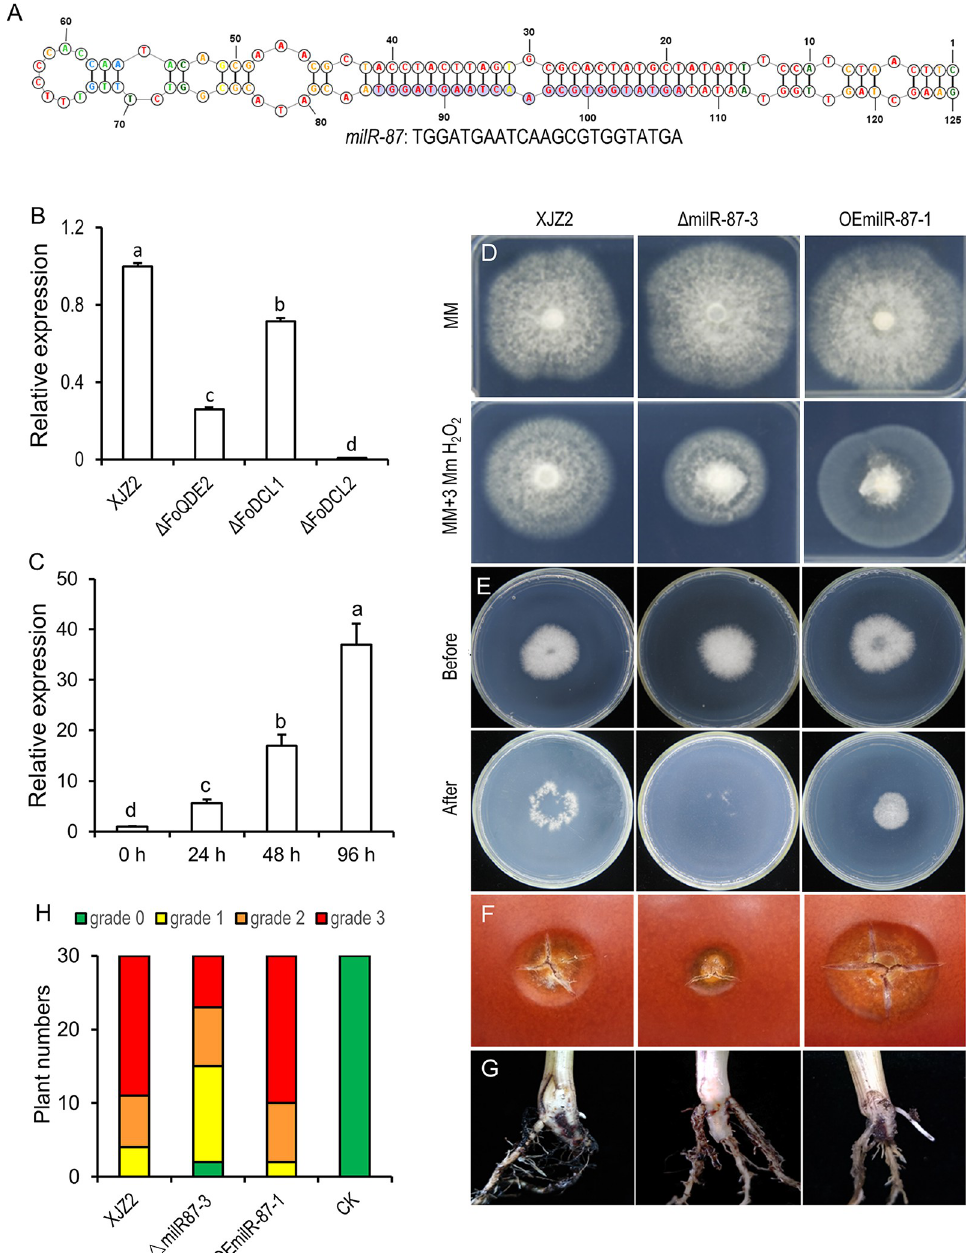
Fig 5. Characterization of FoQDE2-dependent milRNA ( milR-87 ) in F . oxysporum f. sp. cubense ( Foc ). ( A ) Predicted secondary structure of milR-87 precursor in Foc . ( B ) MilR-87 expression in different milRNA biosynthetic pathway gene deletion mutants ( Δ FoQDE2 , Δ FoDCL1 , and Δ FoDCL2 ) by qRT-PCR. Error bars indicate S.D. (n = 3). Different letters indicate significant difference at the level of α = 0.01. ( C ) Expression patterns of milR-87 at 0, 24, 48, and 96 hours post inoculation. Total RNAs were extracted from the host banana roots inoculated with Foc at the different time point (0–96 h). Relative expression levels of milR-87 were calculated by 2 - ΔΔ Ct method using snRNA (U4) as internal control. Error bars indicate S. D. (n = 3). Different letters indicate significant difference at the level of α = 0.01. ( D ) Mycelial sensitivity to H 2 O 2 . Mycelial growth of the WT strain XJZ2, the Δ milR-87 mutant ( Δ milR-87-3 ) and milR-87 over-expression strain OEmilR-87-1 were measured at MM with 0 and 3 mM H 2 O 2 . ( E ) Cellophane penetration assay comparing the invasive growth of the XJZ2, Δ milR-87 mutant and OEmilR-87 strain. Conidia suspensions (100 μ l per strain) with same concentration of 1 × 10 5 spores/ml were put on cellophane-covered PDA plates and incubated at 28˚C for 4 days (Before, before cellophane removed), then the cellophane sheets were removed, and samples were incubated for an additional 3 days (After, after cellophane removed) and the colony size indicated mycelial growth were photographed. ( F )